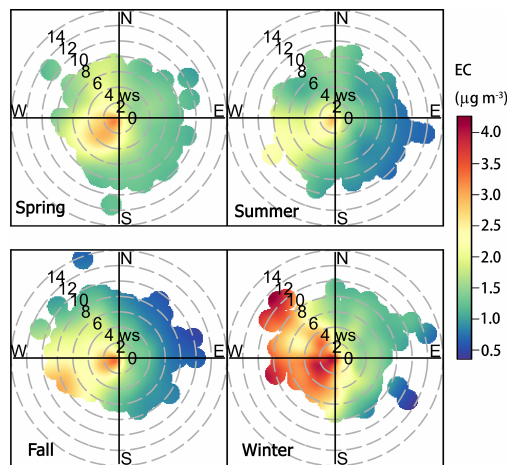
Figure 14. Bivariate polar plots of seasonal EC concentrations (µgm − 3 ) in Shanghai between July 2010 and December 2014. The center of each plot represents a wind speed of zero, which increases radially outward. The concentration of EC is shown by the color